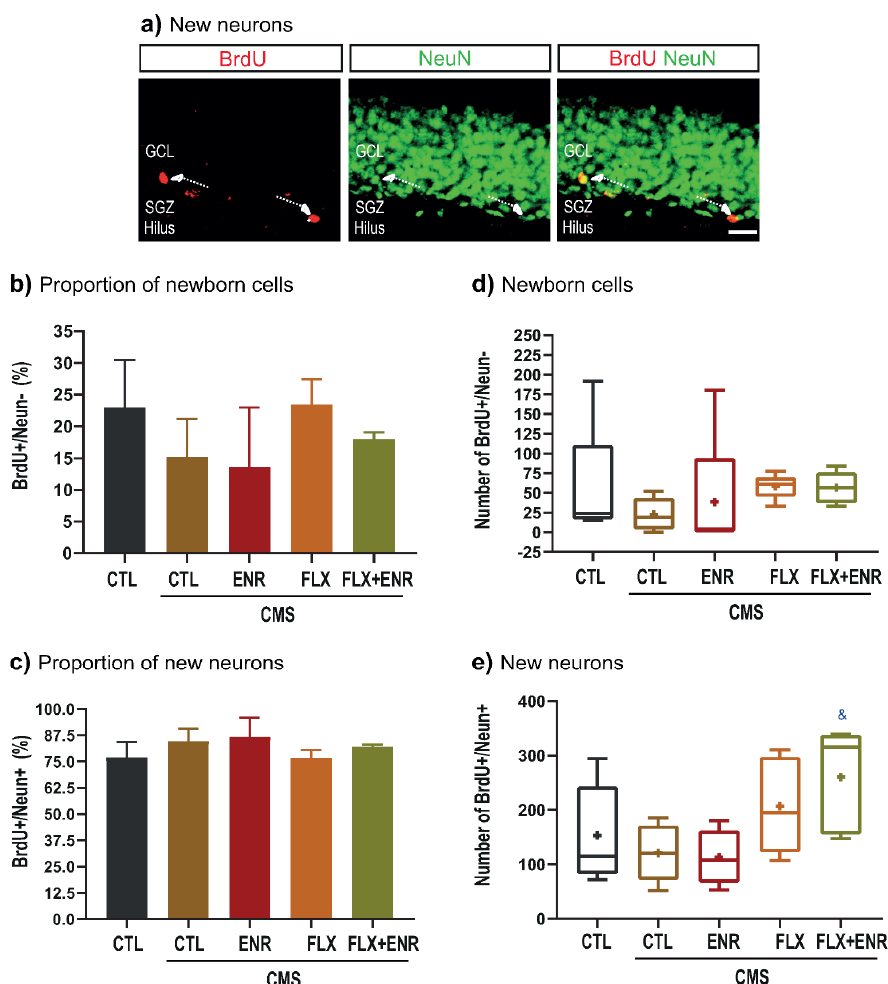
Figure 5. Phenotype of BrdU-positive cells. ( a ) Representative photomicrographs of BrdU-(red) and NeuN-(green) labeled cells. Additionally, the merged picture is shown. Scale bar in a is equal to 30 µm. Proportions of newborn cells ( b ) or new neurons ( c ) are shown without changes among the groups. CTL = unstressed mice, CTL-CMS = stressed mice, ENR = e nvironmental enrichment, FLX = fluoxetine, FLX + ENR = fluoxetine plus environmental enrichment ( n = 5). Data represent the mean ± standard error of the mean (SEM). Absolute number of newborn cells ( d ) or new neurons ( e ) quantified in all groups exposed or not exposed to CMS. Data are presented as the mean ± standard error of the mean (SEM). n = 5. Symbol in ( e ) “&” indicates p ≤